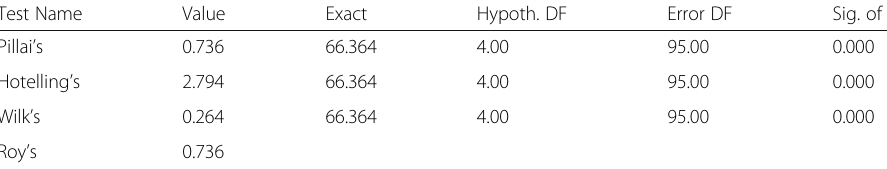
Table 7 Statistical Significance Tests for the Full Canonical Correlation Analysis